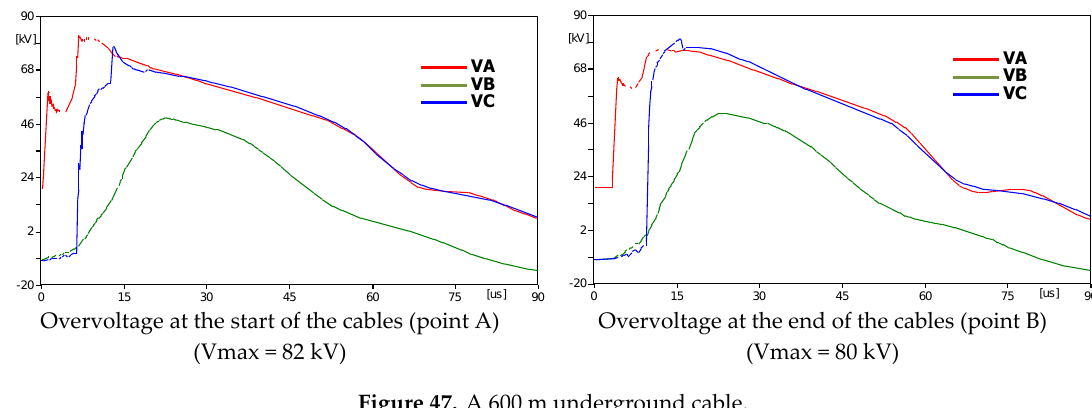
Figure 46. A 500 m underground cable.